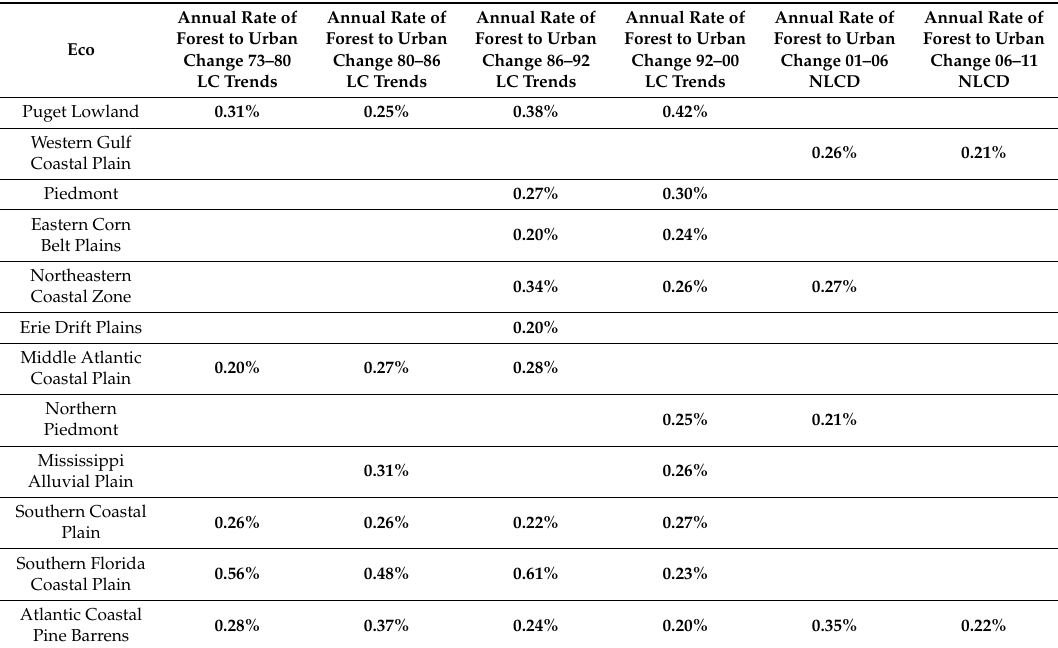
Table 3. Ecoregions reaching or exceeding the rate of 0.2% annual forest to developed land cover change in any or all time intervals (all time intervals in bold).